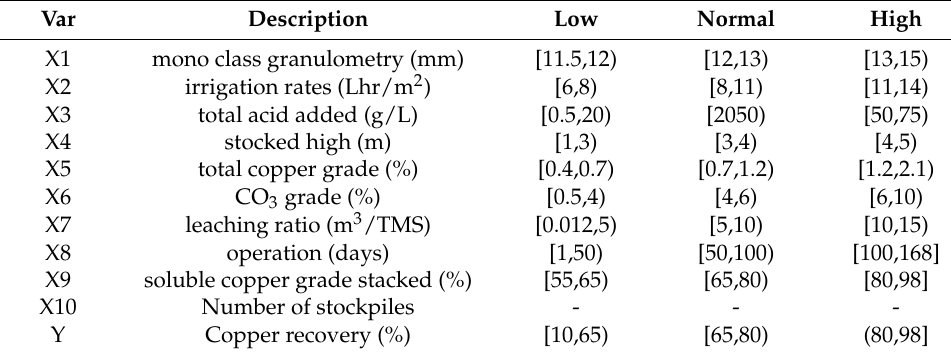
Table 1. Entry parameters of the statistical model. Variables X1–X10 are predictive, Y corresponds to the class or dependent